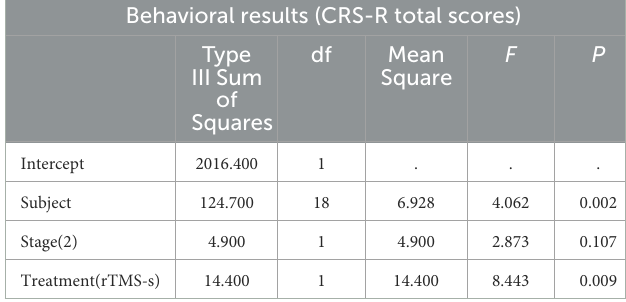
TABLE 2 Univariate general linear model ANOVA for the CRS-R behavioral results. Behavioral results (CRS-R total